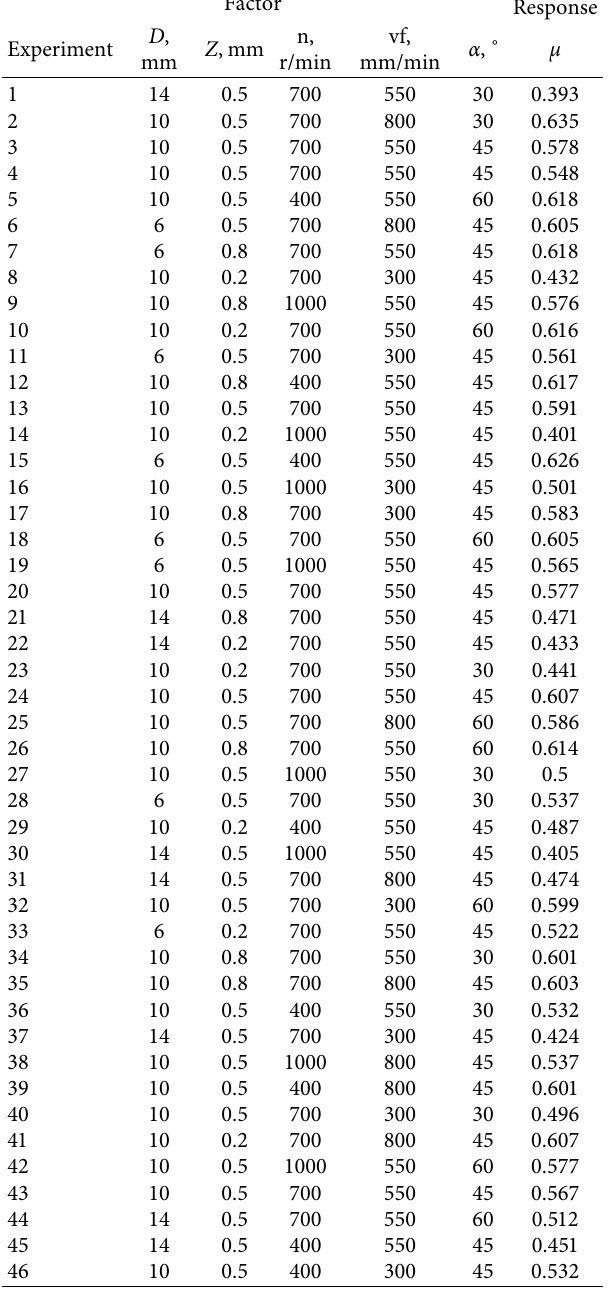
Table 3: The experimental scheme and results.